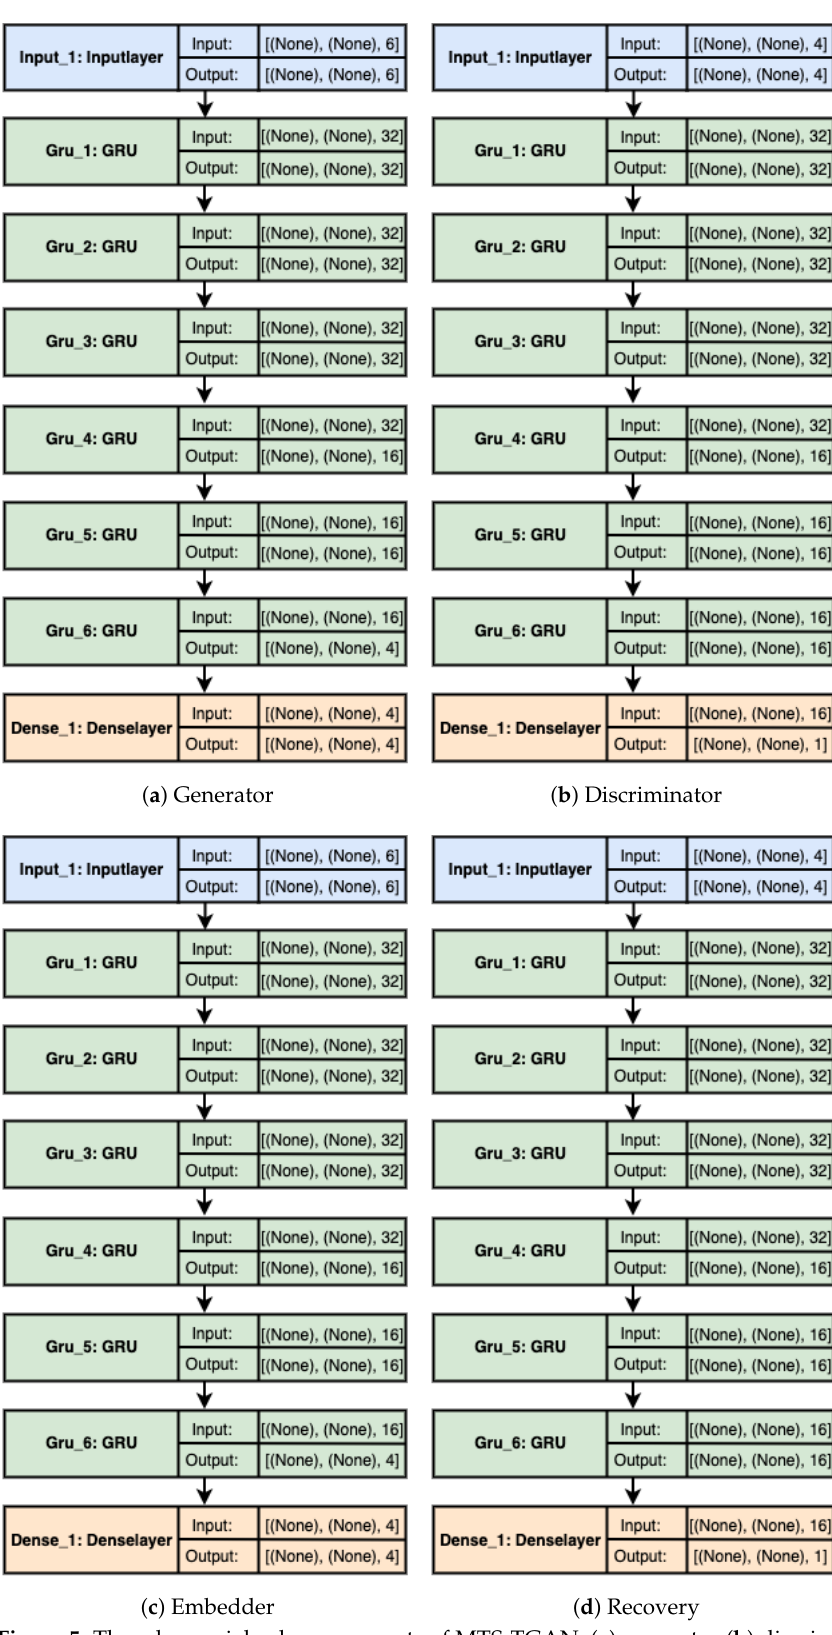
Figure 5. The adversarial sub-components of MTS-TGAN: ( a ) generator ( b ) discriminator and the auto-encoding sub-components of MTS-TGAN: ( c ) embedder ( d ) recovery functions,